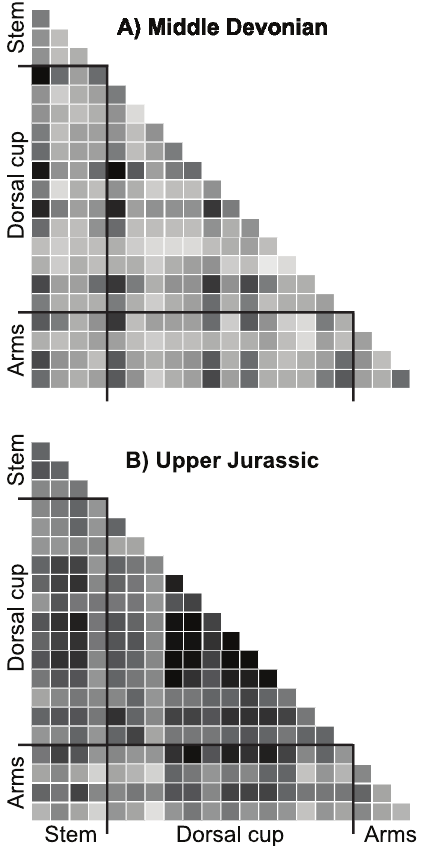
Figure 4. Matrices of mutual compatibility for Palaeozoic and post-Palaeozoic crinoids. These two matrices exemplify the differences in patterns of integration between (A) Palaeozoic (Middle Devonian, MD) and (B) post-Palaeozoic crinoids (Upper-Jurassic, UJ). The choice for these two time intervals has been driven by their location in the space of correlation matrix (separation along PCo1; see Figure 3) and the comparability of their sets of applicable characters (number and distribution over the whole character matrix). The gray-scale correlates with the strength of mutual compatibility ( , correlation): the darker the gray, the higher the compatibility. The comparison of these two matrices shows the overall stronger integration among characters within the post-Palaeozoic matrix and its heterogeneous structure with larger blocks of compatible characters (e.g., stem and dorsal cup characters, arm and dorsal cup characters). integration and occupy a different region of the space of correlation matrices. Their location indicates heterogeneously structured correlation matrices with larger blocks of correlated traits, which could explain the less disparate and more stereotyped post-Palaeozoic morphologies reported previously [19]. Hence, if the amount of morphological disparity does not appear to be conditional upon any given degree of overall integration, the results suggest that disparity is related to the modular nature of the correlation matrix, that is, to its pattern of organization into evolutionarily quasi-independent blocks of integrated traits. With regards to the two competing hypotheses presented in the introduction, the temporal trajectory of morpho- logical disparity in crinoids would then be tied to changes in the pattern of correlation among traits rather than to changes in their individual variability.